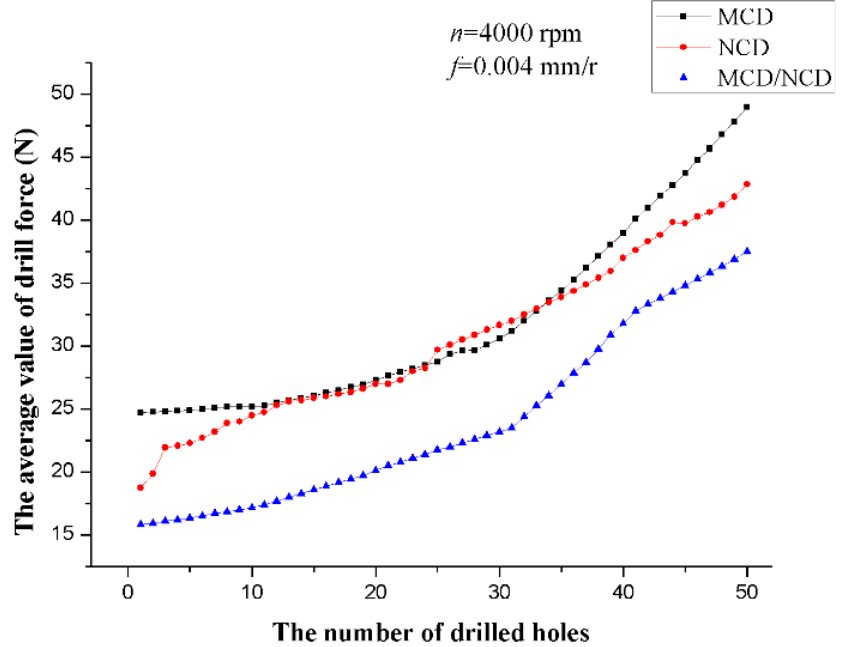
Figure 6. Force value versus the number of drilled holes under condition I.